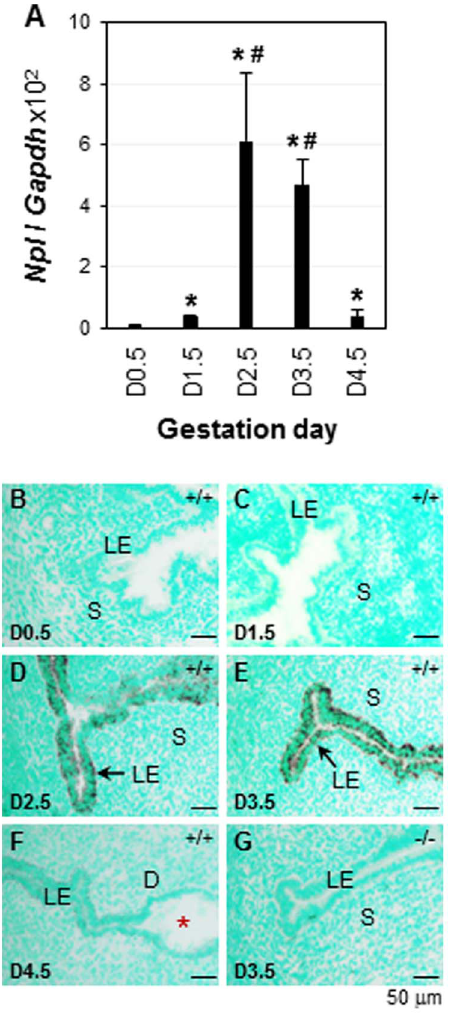
Figure 1. Expression and localization of Npl in the periimplan- tation mouse uterus. A. Expression of Npl in the periimplantation wild type (WT) uterus using realtime PCR. N=4–6. * p , 0.05, compared to gestation day 0.5 (D0.5); # p , 0.05, compared to D1.5 and D4.5. Gapdh (glyceraldehyde 3-phosphate dehydrogenase), a house keeping gene as a loading control; error bars, standard deviation. B–G. Localization of Npl in the periimplantation uterus by in situ hybridization using Npl antisense probe. B. D0.5 WT ( + / + ) uterus. C. D1.5 WT uterus. D. D2.5 WT uterus. E. D3.5 WT uterus. F. D4.5 WT uterus. G. D3.5 Npl ( 2 / 2 ) uterus. Red star, embryo; LE, luminal epithelium; S, stroma; D, decidual zone; scale bar, 50 m m. N=2–3.